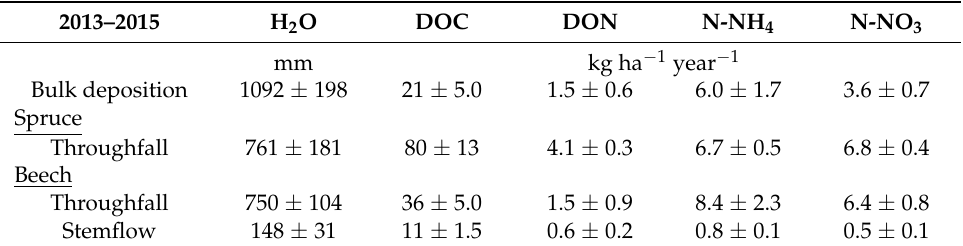
Table 4. Fluxes ( ± standard deviation) of water (mm), DOC and N (kg · ha − 1 · year − 1 ) in bulk deposition,